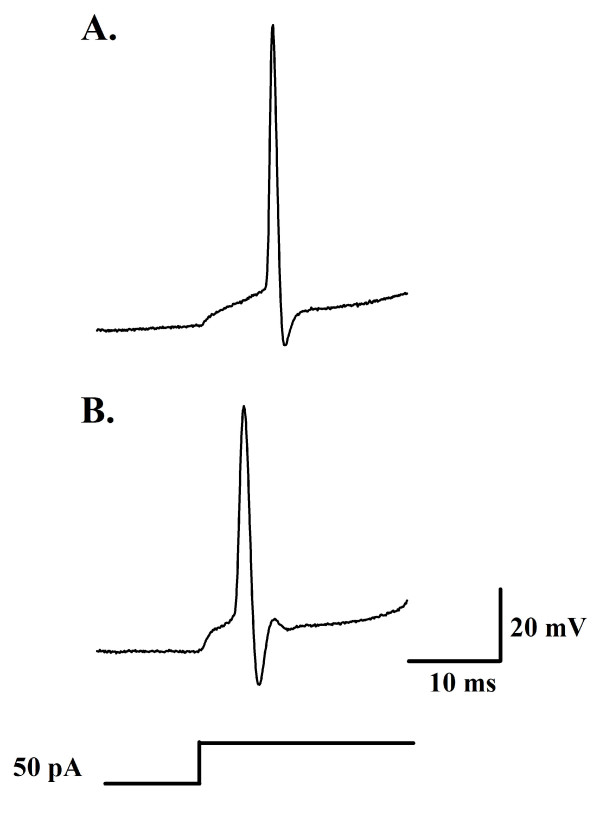
The effect of depolarizing current and PGE2 on the activity of a VMPO temperature insensitive neuron. A shows the initial action potential that was produced during baseline conditions, in response to a depolarizing current injection (50 pA, 500 msec). The onset of the current is indicated on the line at the bottom of the figure and only the initial 34 mSec are shown. The first spike latency was 8.0 mSec. In B, the initial action potential that was produced in response to a depolarizing current injection is shown during perfusion with PGE2 (1 μM). The first spike latency was 3.0 mSec.